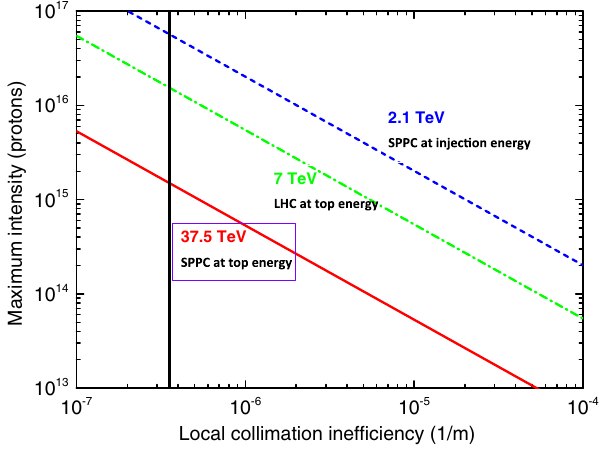
FIG. 5. The maximum total intensity is shown as a function of the local cleaning inefficiency for SPPC injection, top energy, and the LHC top